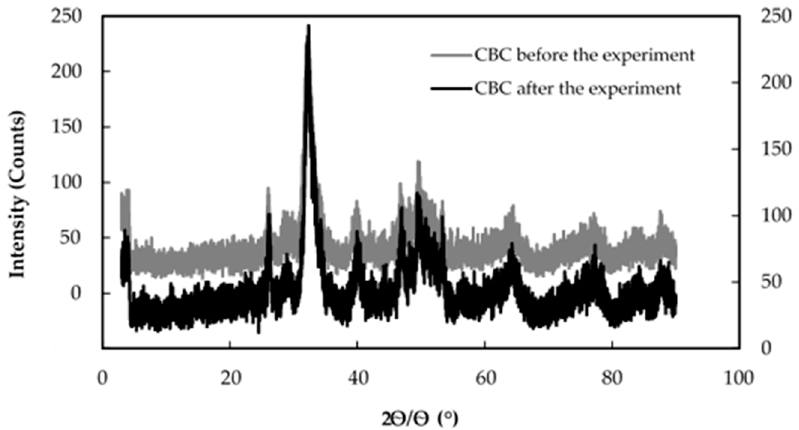
Figure 5. X-ray diffraction patterns of CBC before and after the fluoride adsorption. CBC before the experiment (left Y axis), CBC after the experiment (right Y axis).